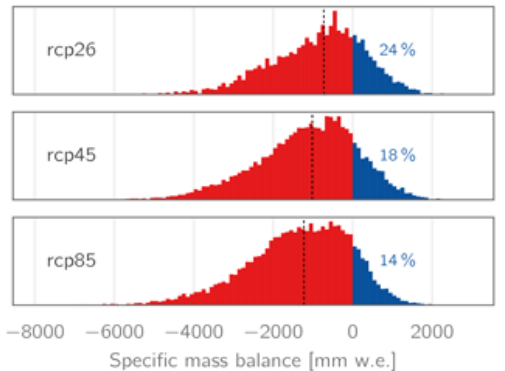
Figure 20. Histograms of the specific mass balance values as sim- ulated for all (initially) 206 study area glaciers, all simulation years (2006–2100), and all GCM–RCM combinations. Dashed ver- tical lines refer to the median mass balance, and percentages indi- cate the total fractions of positive mass